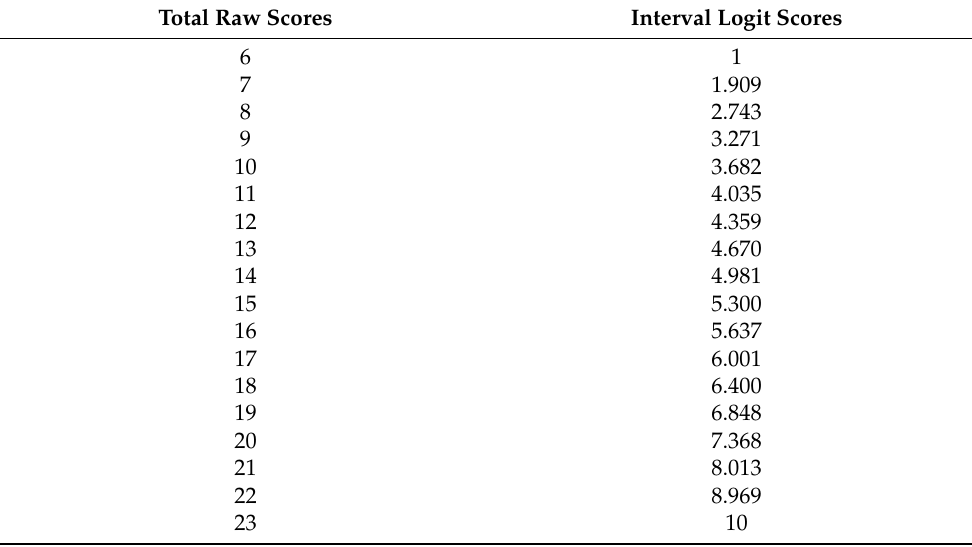
Table 4. Conversion table of total raw scores to Robust Italian Validation of the Coping Humor Scale (RI-CHS) interval scale logit scores.